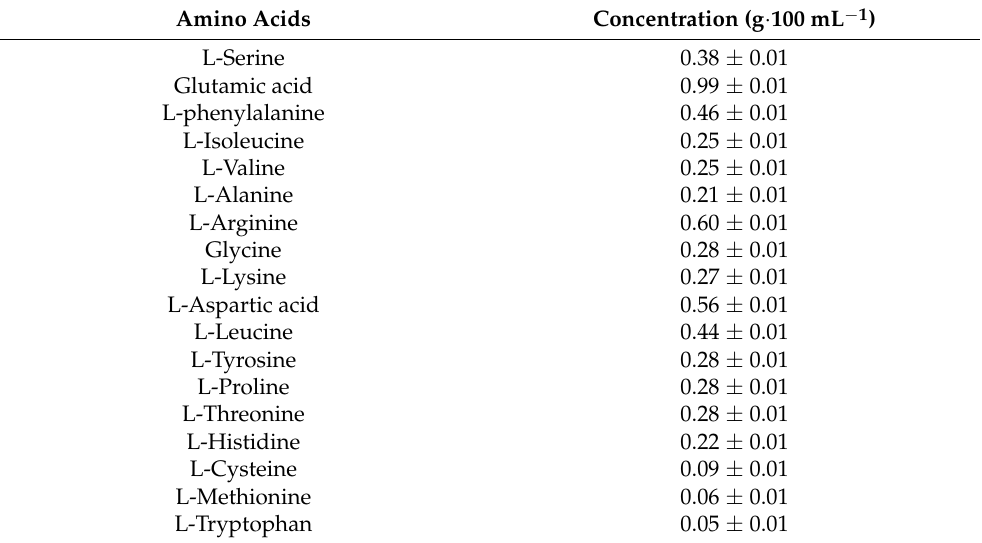
Table 3. Amino acid composition of black soy